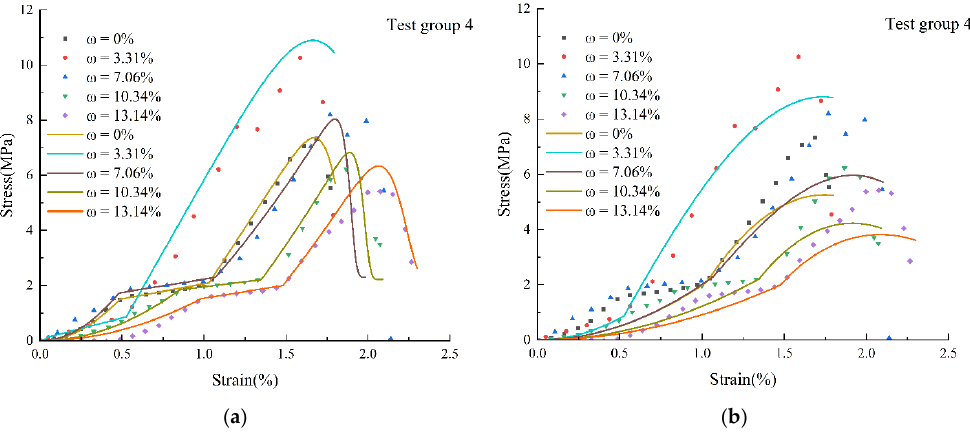
Figure 12. The uniaxial compression test data points and theoretical model curve of coal samples in test group 4: ( a ) the author’s model; ( b ) the comparison model.